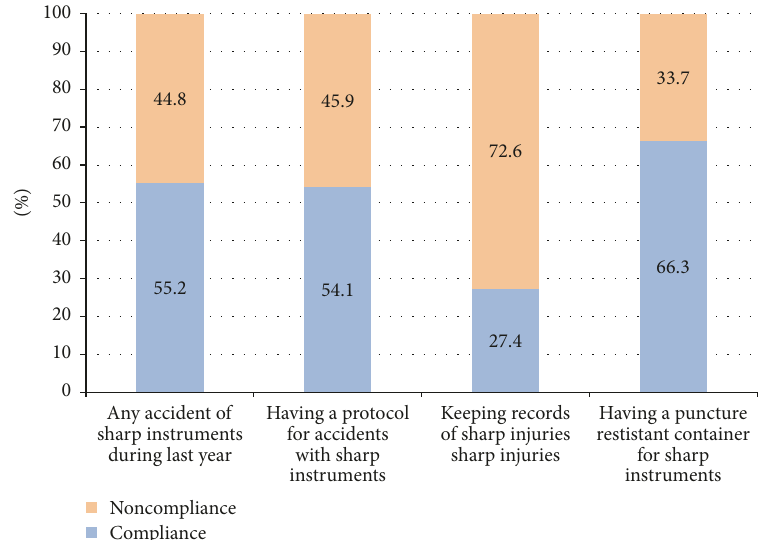
Figure 3: Graph summarizing the occurrences of sharp injuries and prophylactic measures adopted in the surveyed Lebanese private clinics